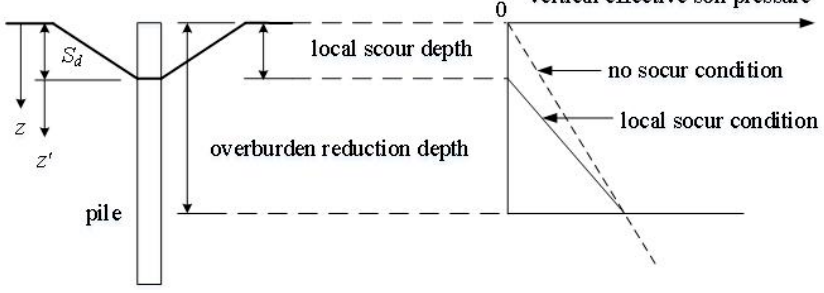
Figure 3. Schematic for the influence of scour on effective stress (suggested by API [6] and Zaaijer